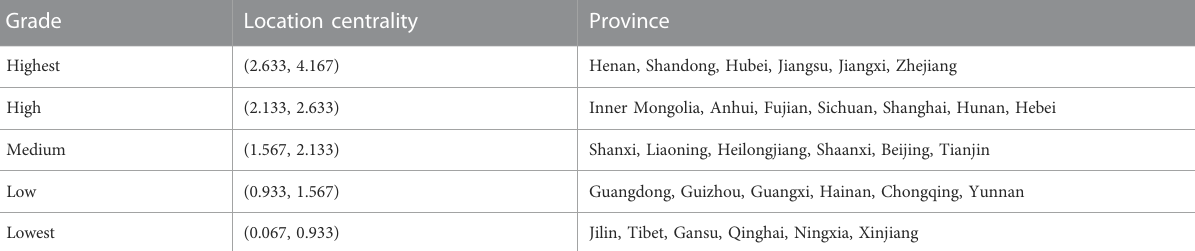
TABLE 3 Spatial distribution of location